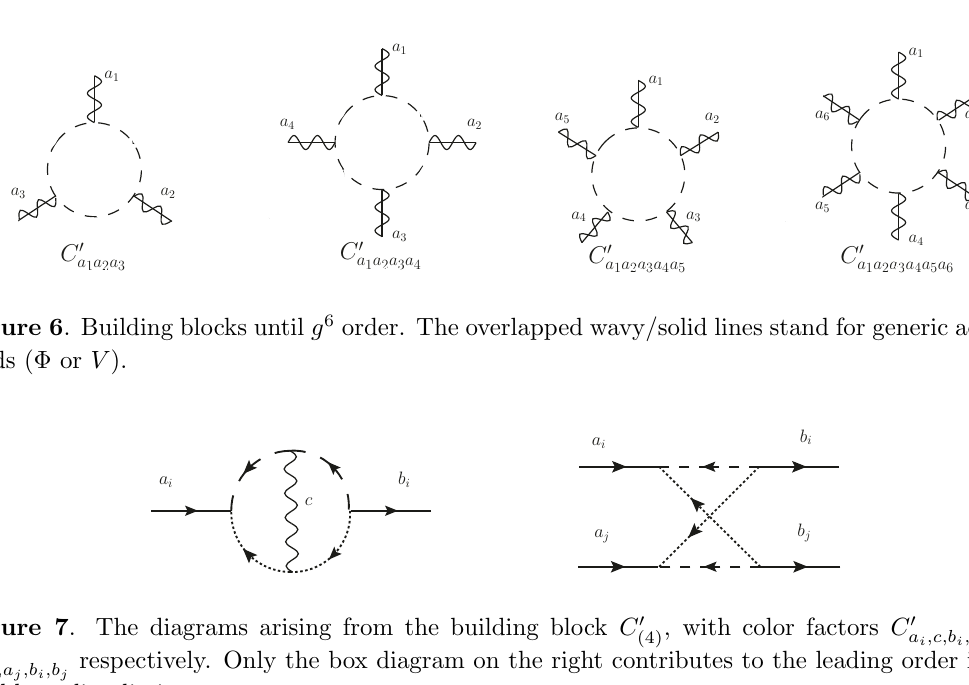
, with color factors C 0 and a i ;c;b i ;c (4)